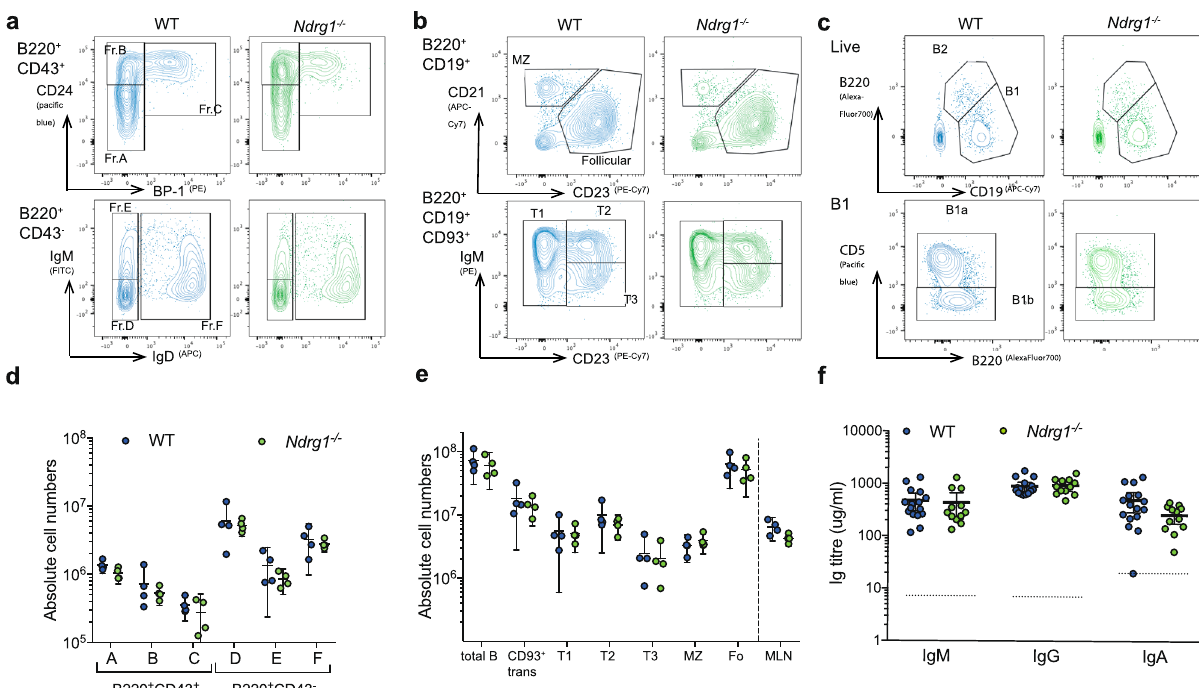
Fig. 3 Normal B cell development in the absence of NDRG1. a Representative fl ow cytometry plots of adult WT (blue) and Ndrg1 − / − (green) mice, showing Hardy B cell fractions in BM ( a ), and splenic ( b ) and peritoneal ( c ) B cell subsets. d Quanti fi cation of absolute BM B cell numbers as gated in ( a ). e Quanti fi cation of B cell subsets, transitional (trans), transitional populations (T1 – T3), marginal zone (MZ) and follicular (Fo) numbers in the spleen and total B cells in MLNs as gated in ( b ). Points are individual mice, lines represent means with 95% CI error bars and are representative of three independent experiments, each with 3 – 6 mice per group. f Serum Ig levels from WT and Ndrg1 − / − mice determined by ELISA. Points are individual mice and lines represent means with 95% CI error bars with 12 – 16 mice per group. Dotted line represents 1.5× interpolated background